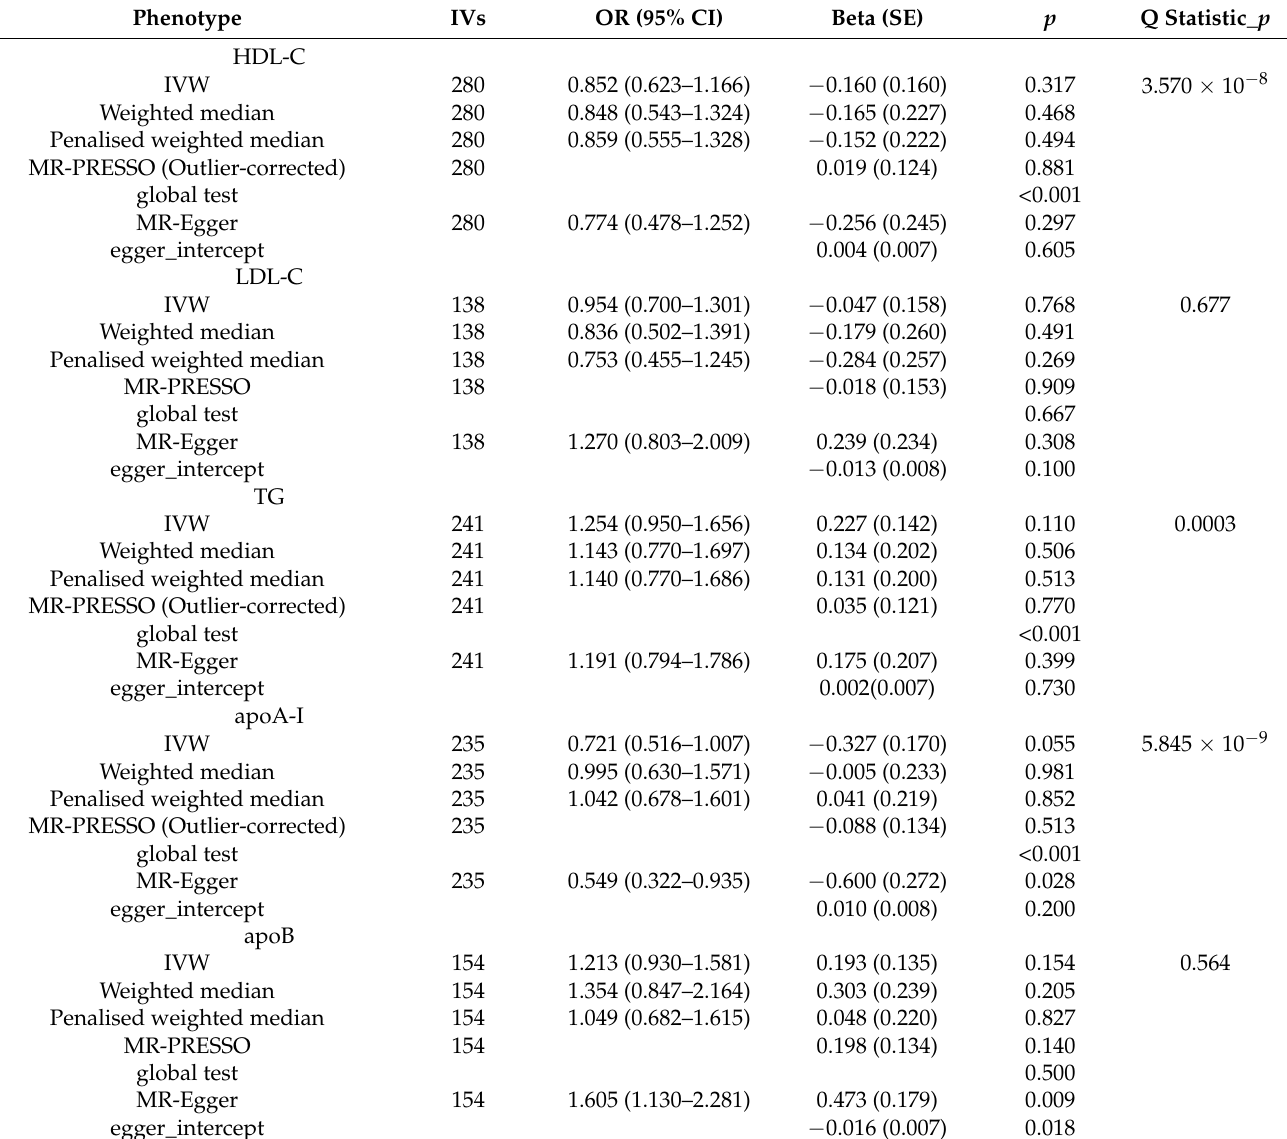
Table 1. Causal effects of lipid-related traits levels on vascular dementia via univariable MR